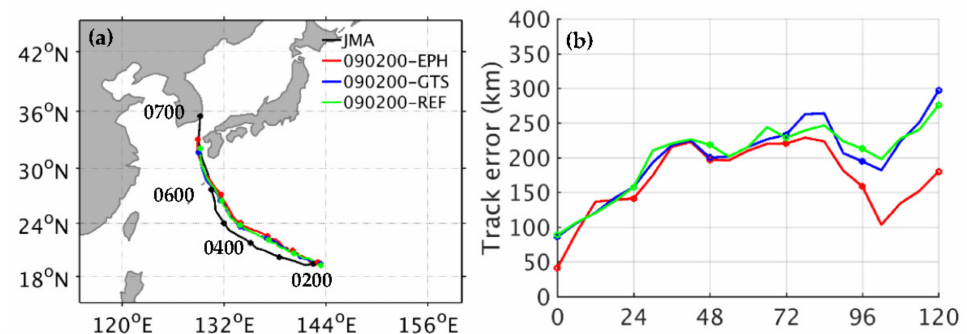
Figure 12. ( a ) Simulated tracks of Haishen for 090200-EPH (red line), 090200-GTS (blue line), and 090200-REF (green line) experiments and the best tracks of JMA (black line). The simulated time was from 0000 UTC 2 September to 0000 UTC 7 September 2020. ( b ) as in ( a ) but for track error. Circle symbols mark the typhoon centers every 24